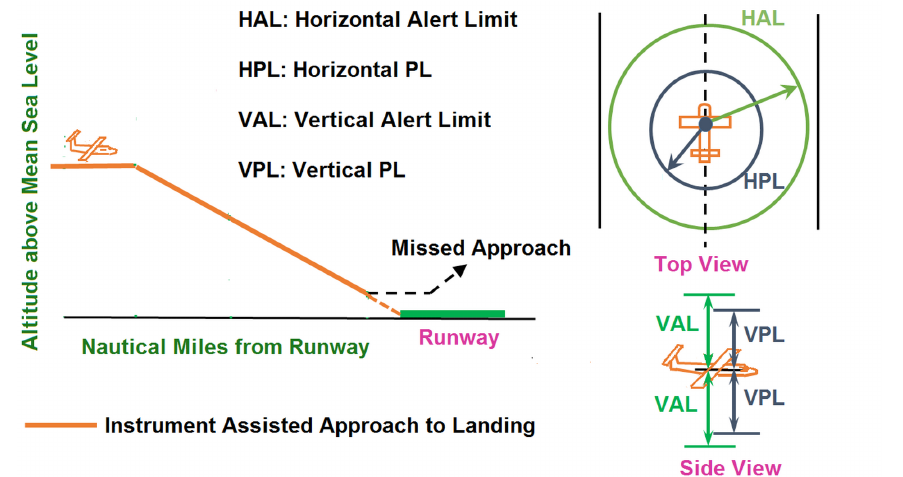
Figure 1. Illustration of PLs. To ensure reliability, magnitude of error in the estimated position (both horizontal and vertical) must be within the corresponding PL with a certain probability. Calculated PLs must be below the alert limits when integrity monitoring is